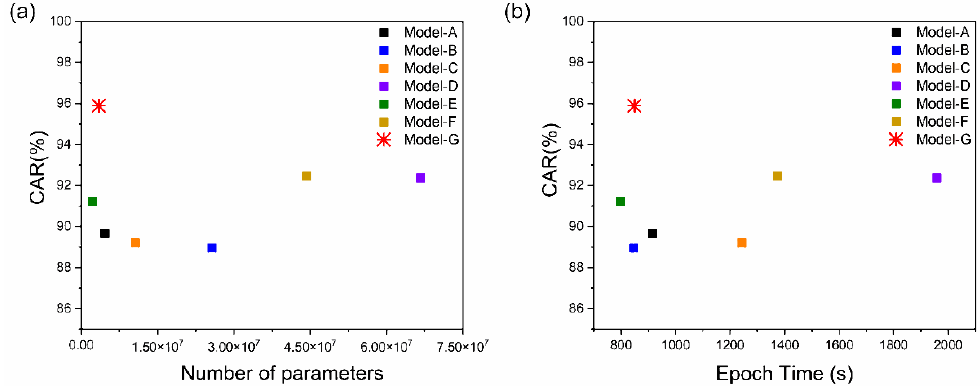
Figure 10. CAR of the baseline and other models according to the ( a ) number of parameters; ( b ) average epoch time.